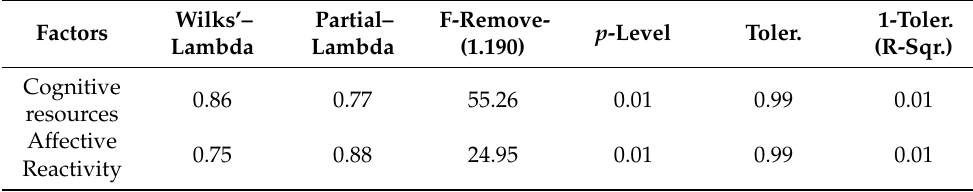
Table 5. Summary of the discriminant function